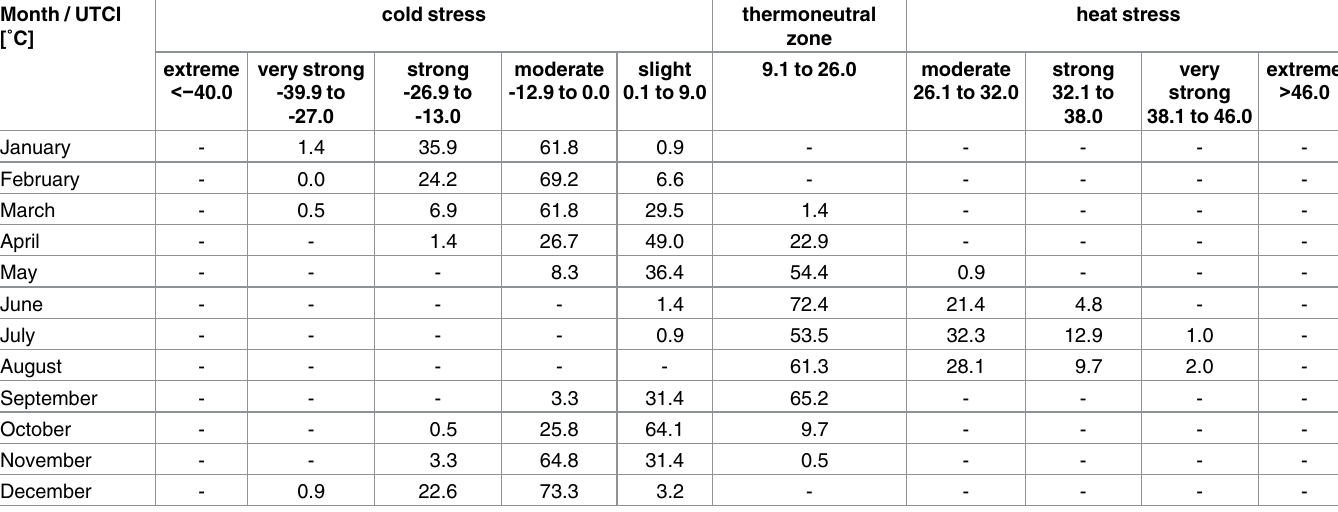
Table 3. Frequency (%) of thermal stresscategories determined on the basis of